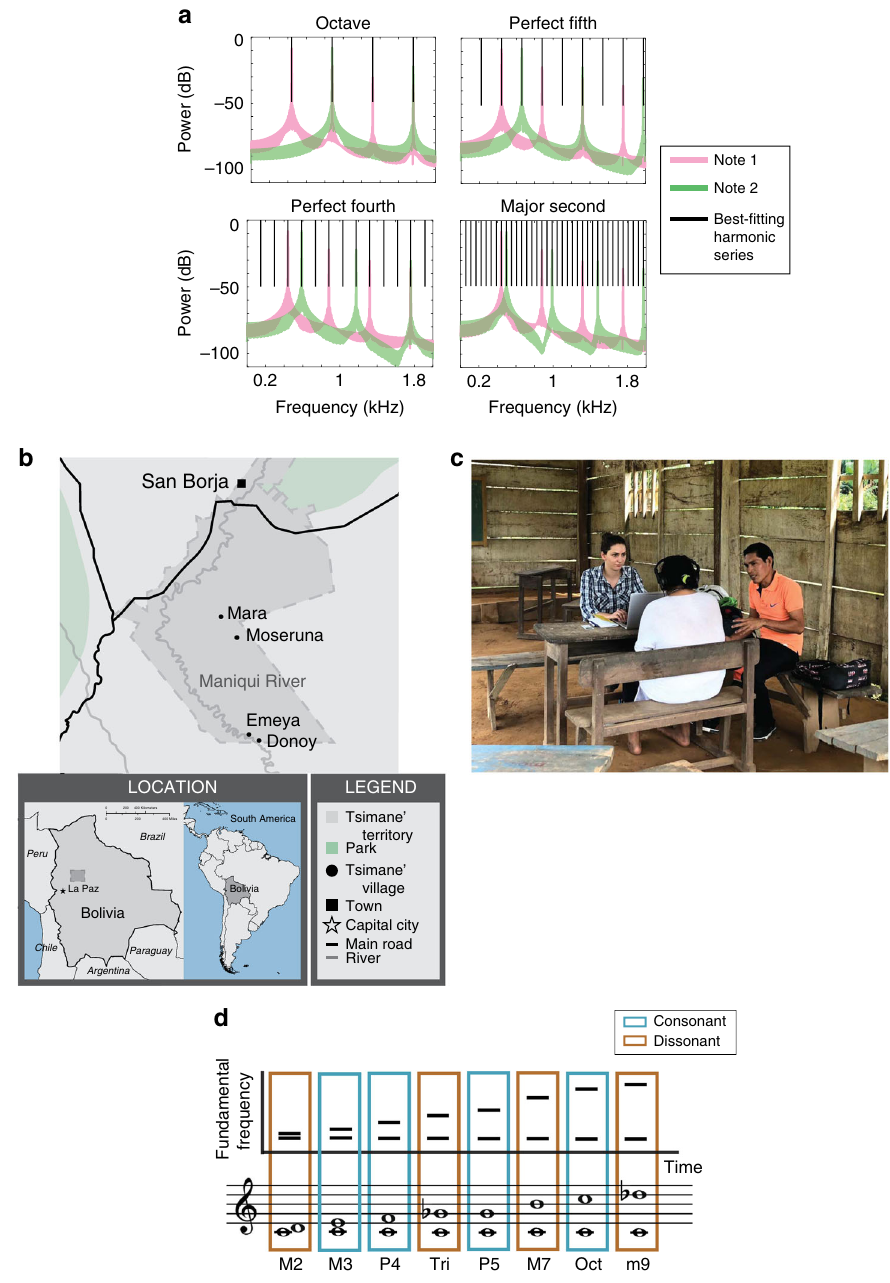
Fig. 1 Stimuli and experimental setup. a Frequency spectra of example musical interval stimuli, each generated from the superposition of two harmonic notes separated by a particular pitch interval. Canonically consonant intervals such as the octave, perfect fi fth, and perfect fourth produce aggregate spectra whose frequencies approximate harmonics of a common fundamental frequency (f0). The octave has the greatest overlap with the best matching harmonic series, followed by the fi fth, and then the fourth. Canonically dissonant intervals such as the major second produce an aggregate set of frequencies that are consistent only with a much lower f0, and that produce little overlap with its harmonics. b Map of the region of Bolivia where testing occurred. Tsimane ’ participants were residents of the villages of Mara, Moseruna, Emeya, and Donoy. c Example of experimental conditions; photo depicts an experiment conducted in a classroom. Sounds were presented over closed headphones using a laptop, and were audible only to the participant (such that the experimenter was blind to the stimulus being presented). A translator (shown here with the orange shirt) assisted in explaining the experiments and interpreting responses. d Schematic and musical depiction of consonant and dissonant musical intervals used in experiments, showing alternation of consonant and dissonant intervals as interval magnitude (difference between the note f0s)